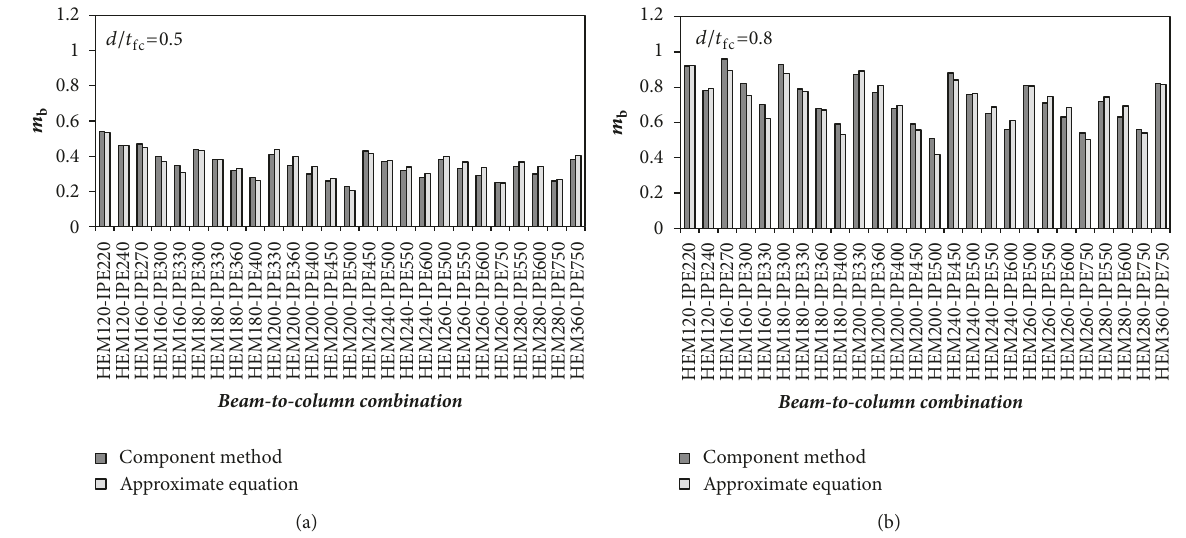
Figure 14: Accuracy of the approximate equations for selected values of the ratio 𝑑/𝑡 fc : normalized resistance.